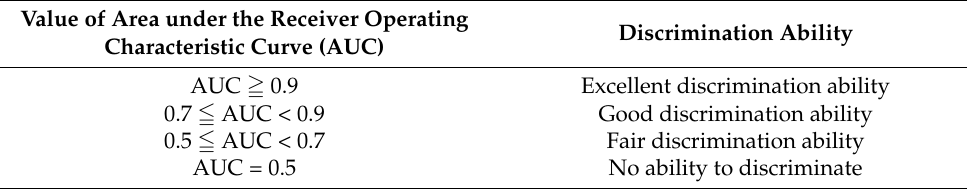
Table 18. Area under curve discrimination-ability thresholds (Hanley and McNeil, 1982) [25]. Value of Area under the Receiver Operating Characteristic Curve